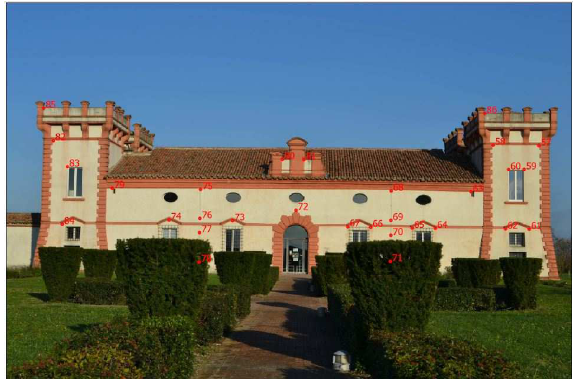
Figure 4. Location of control points on the main façade of the Castle